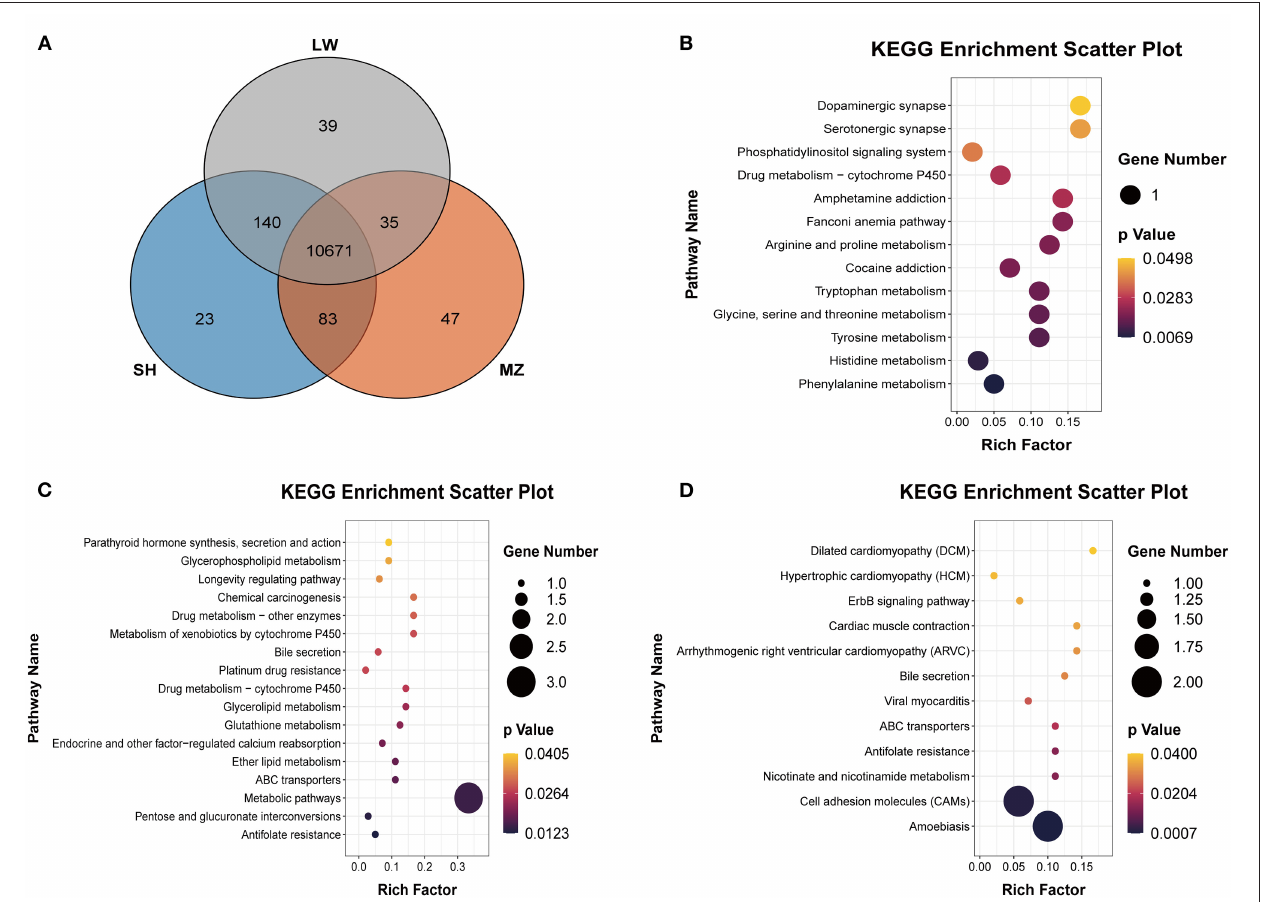
FIGURE 4 | (A) Venn diagram of the CNVRs in LW, SH, and MZ pigs. The known genes of LW (B) , MZ (C) , and SH (D) pigs in the group-specific CNVRs were analyzed in the KEGG pathway.